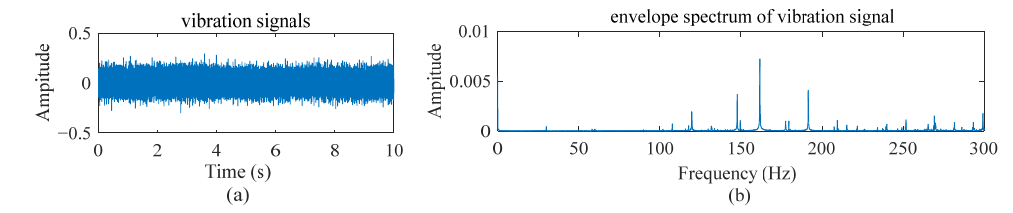
Figure 1. Vibration signal and its envelope spectrum under constant speed working conditions when an inner raceway fault occurs.